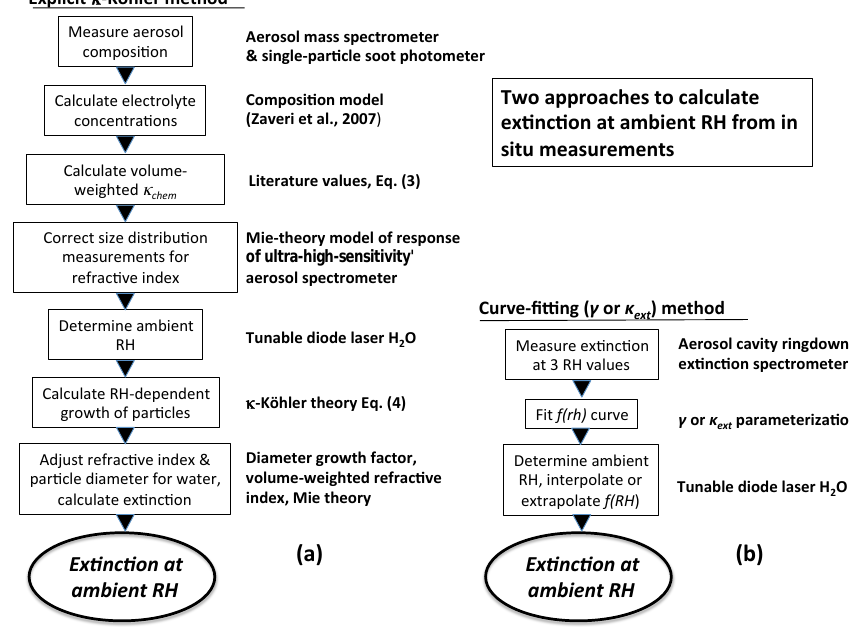
Figure 1. Schematics showing the process of calculating ambient extinction from (a) measurements of composition, size distribution, and ambient RH and (b) measurements of ambient RH and of extinction at three instrument RH